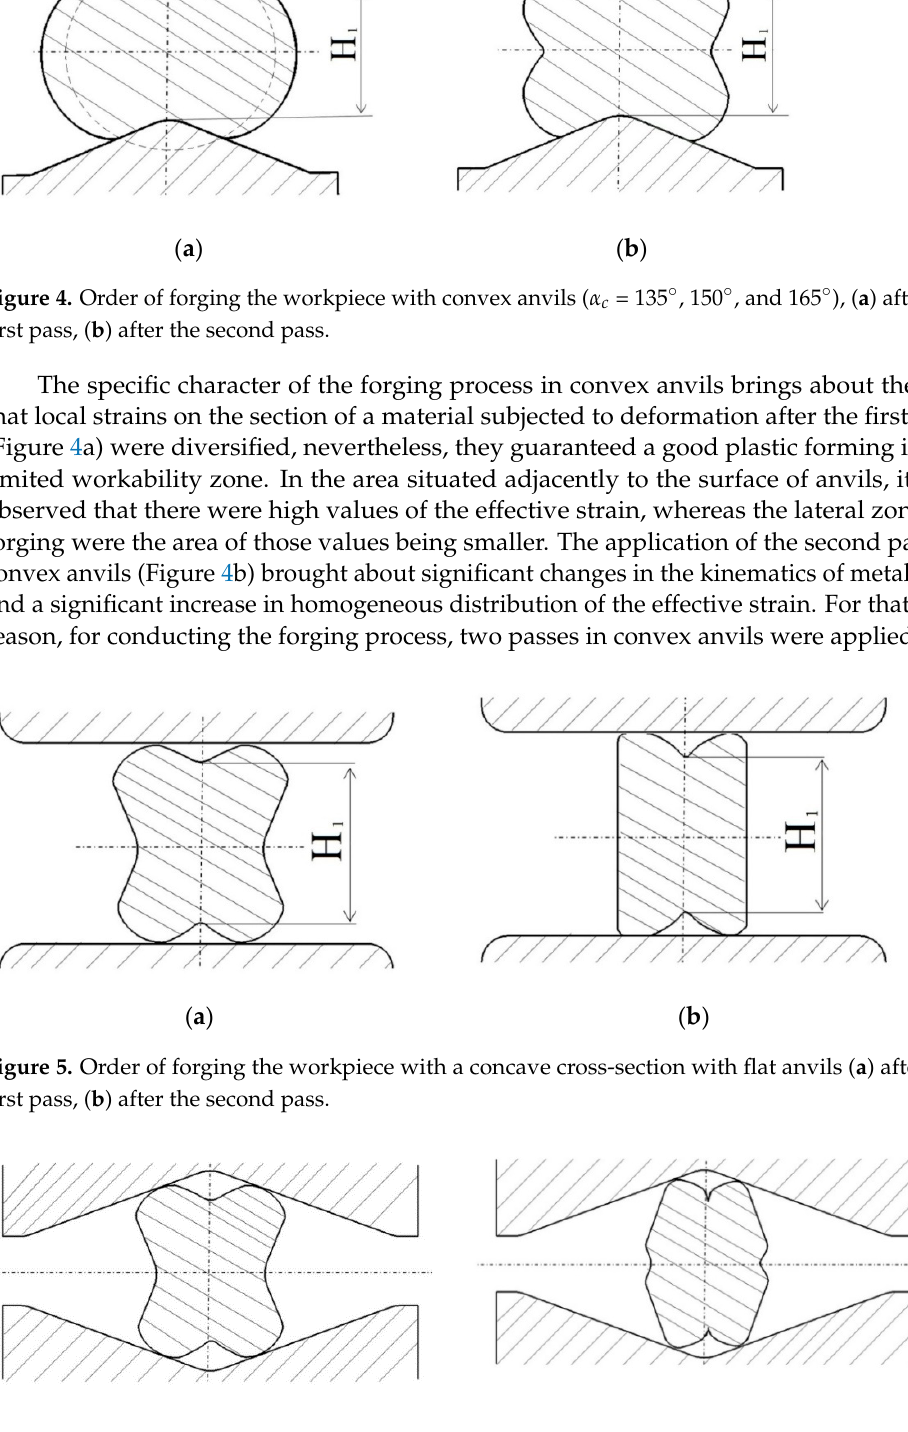
Figure 3. Schematic illustration of the cogging process: ( a ) finite element model for the forging experiment, ( b ) the hitting sequence on the ingot length (l/w d = 0.70; l/D 0 = 0.75), and ( c ) pass sequence for flat anvils (90° rotation).